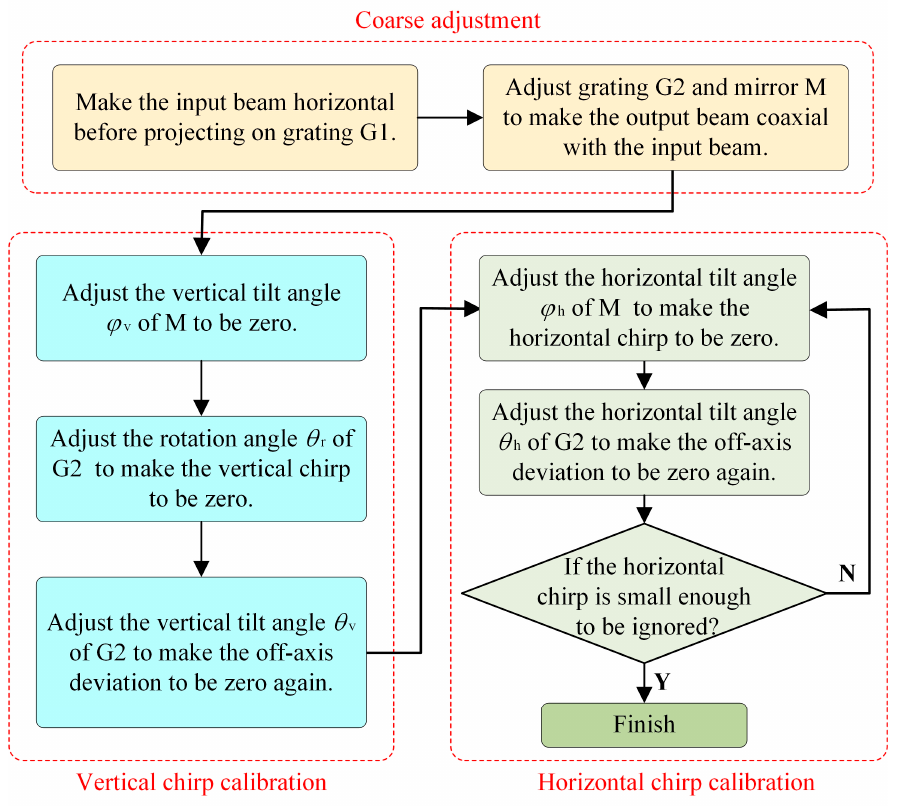
Figure 5. The flow chart to accurately calibrate the misalignments of the stretcher.